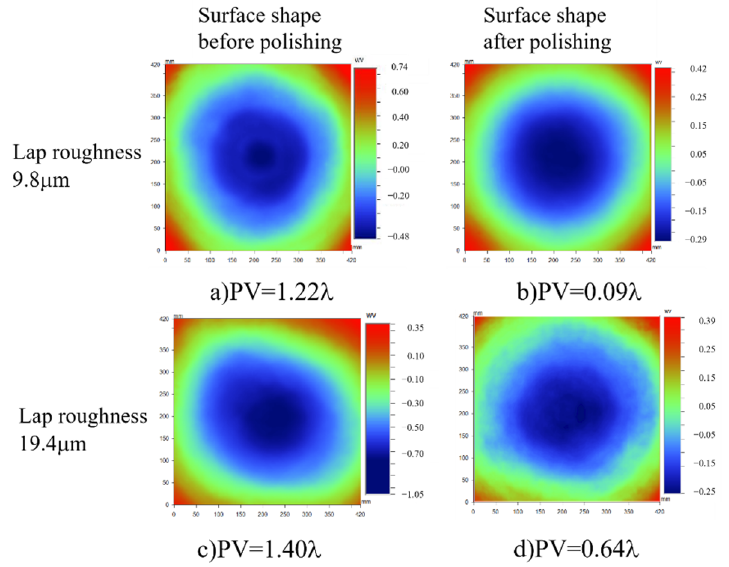
Figure 14. Influence law of roughness on element surface shape. ( a ) Lap roughness is 9.8 μ m before polishing, ( b ) lap roughness is 9.8 μ m after polishing, ( c ) lap roughness is 19.4 μ m before polishing and ( d ) lap roughness is 19.4 μ m after polishing.